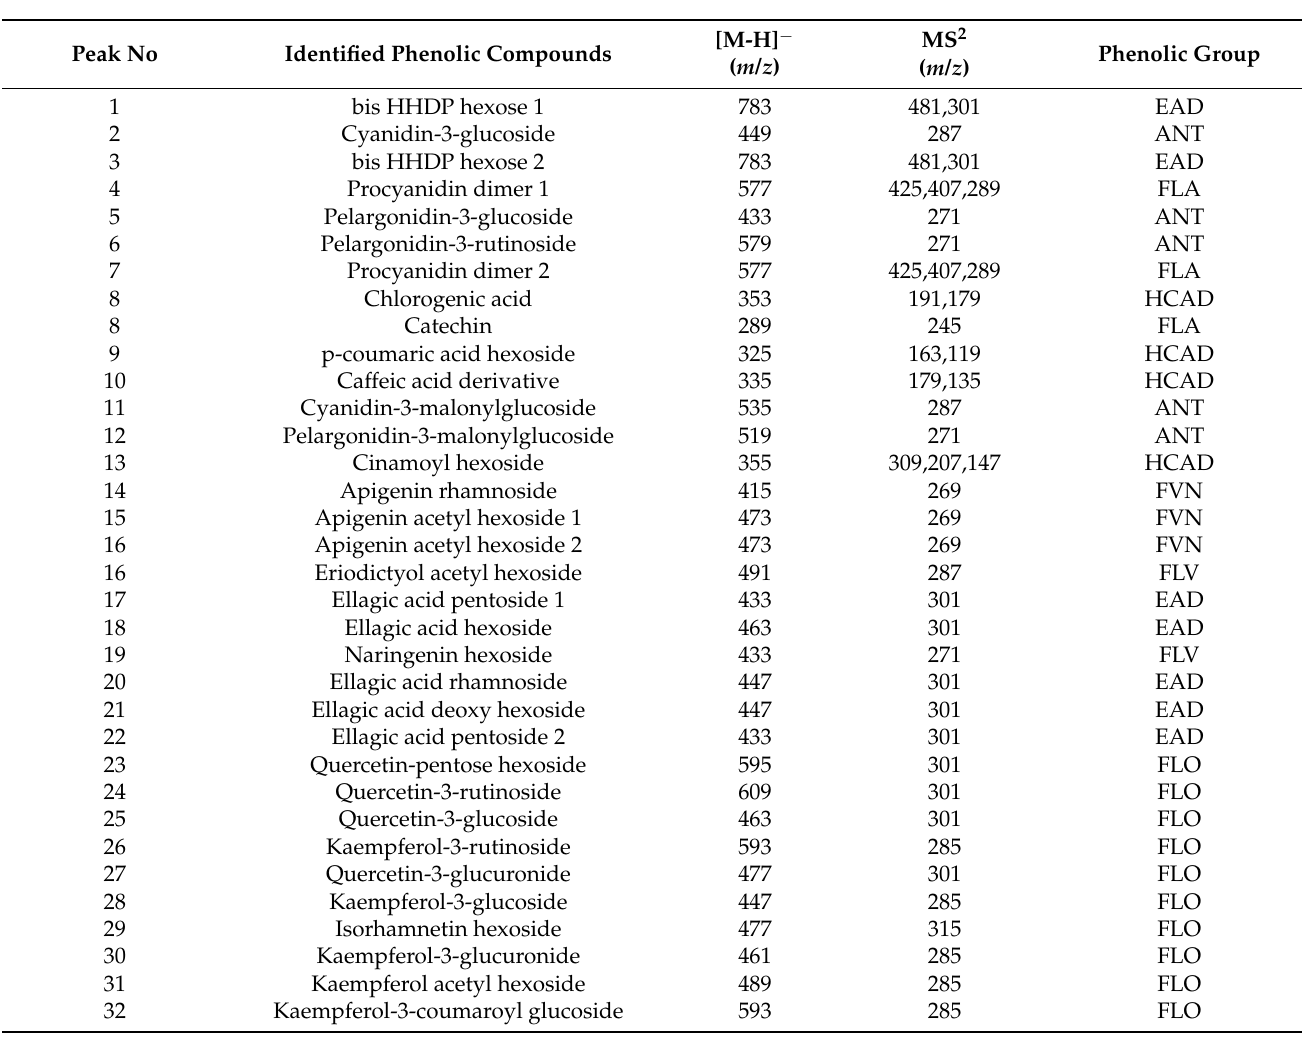
Table 3. Identification of phenolic compounds in strawberry fruit of cv. ‘Clery’ in negative or positive ionization with HPLC-MS and MS 2